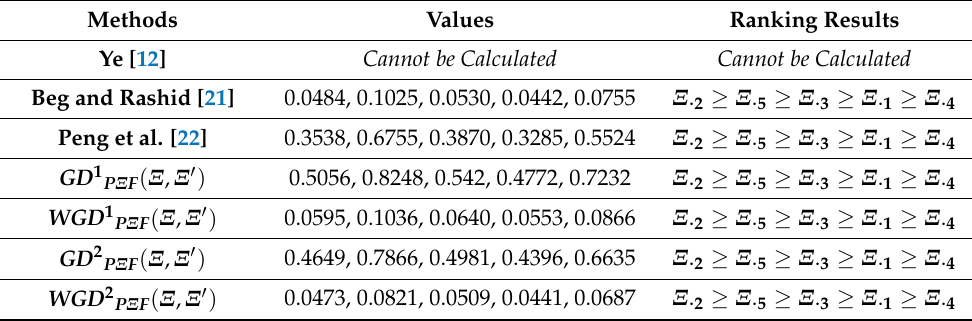
Table 3. Contained comparative